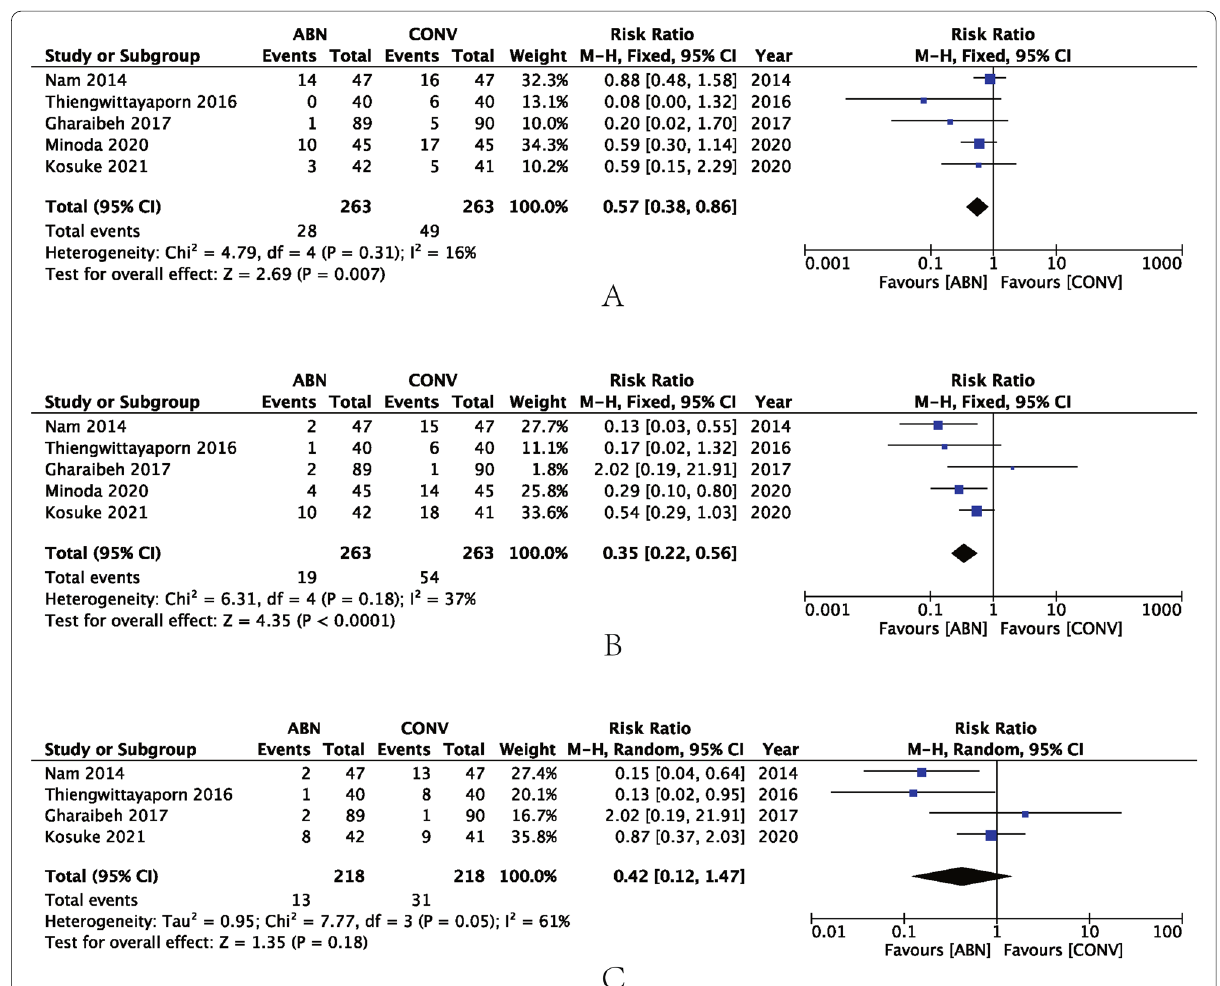
Fig. 6 A Forest plot of coronal femoral angle (CFA) outliers; B Forest plot of coronal tibial angle (CTA) outliers; C Forest plot of tibial slope (TS)